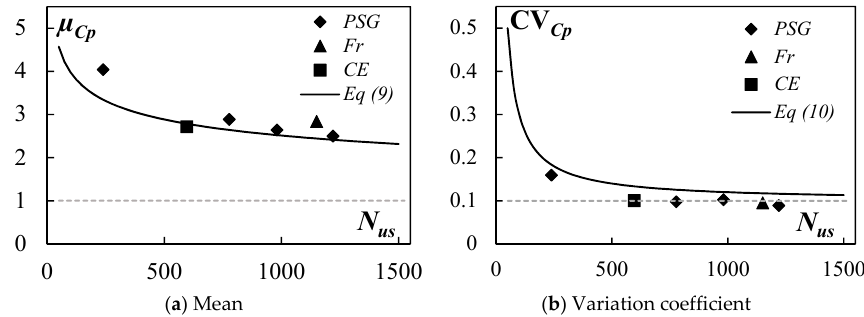
Figure 3. Comparison of the proposed equations and of the observed data for the estimation of the: mean ( a ); and variation coefficients ( b ) of C p versus N us .